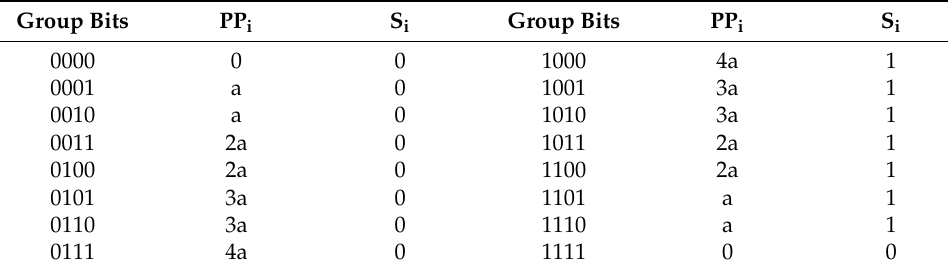
Figure 5. The 16-bit radix-8 Booth multiplier. Table 1. Modified radix-8 Booth